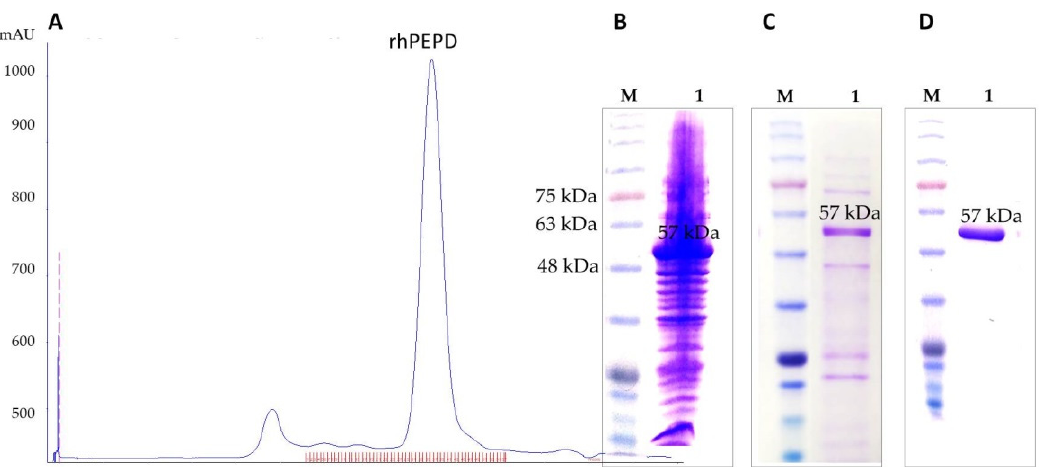
Figure 2. Results of purification and initial characterization of rhPEPD. ( A ) Chromatogram of HiLoad Superdex 200, the final size-exclusion chromatographic purification step recorded at 280 nm. The major peak corresponds to the monomeric form of rhPEPD with an approximate molecular mass of ≈ 50 kDa. SDS-PAGE analysis of rhPEPD. M—molecular weight marker: ( B ) rhPEPD after sonication to soluble fraction before Ni-NTA IMAC step; ( C ) rhPEPD after Ni-NTA IMAC step; ( D ) rhPEPD after size-exclusion chromatographic separation to the major peak of chromatographic fractions.